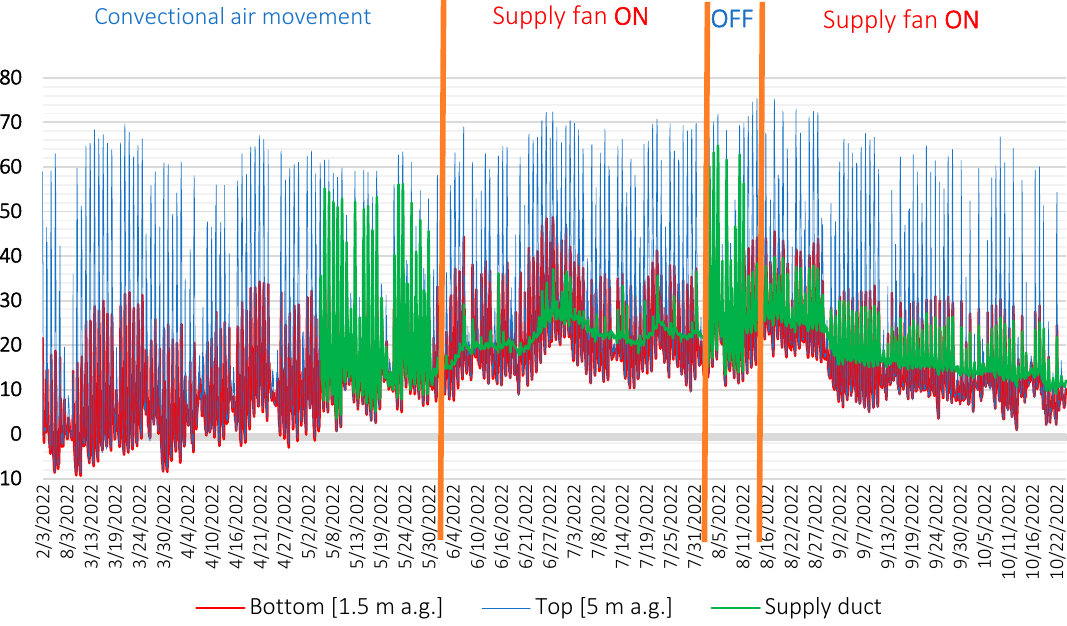
Bottom [1.5 m a.g.] Figure 4. Temperature measurements at the top and bottom of the Trombe wall installed onto a factory building.